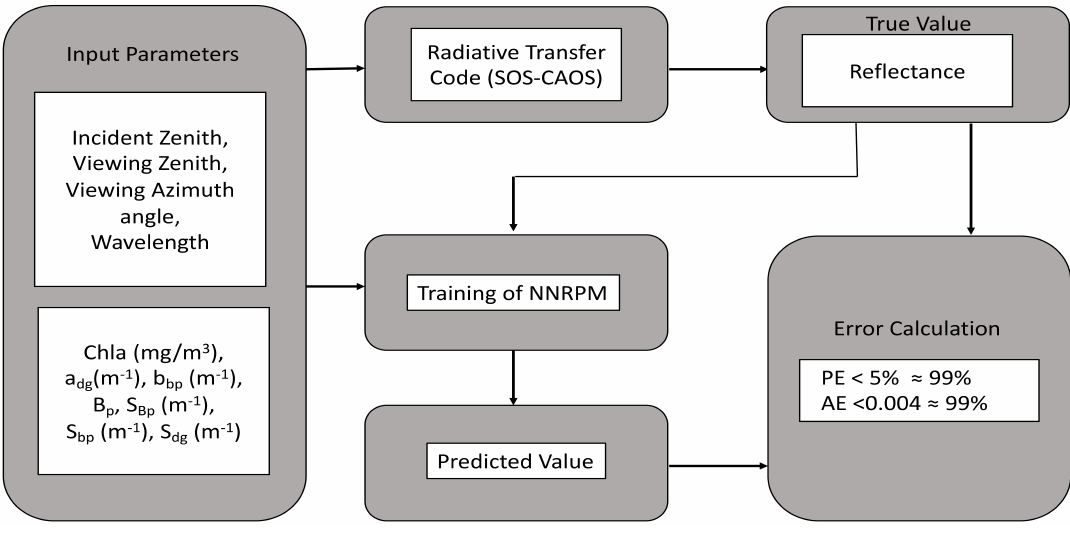
Figure 2. High level flow diagram for